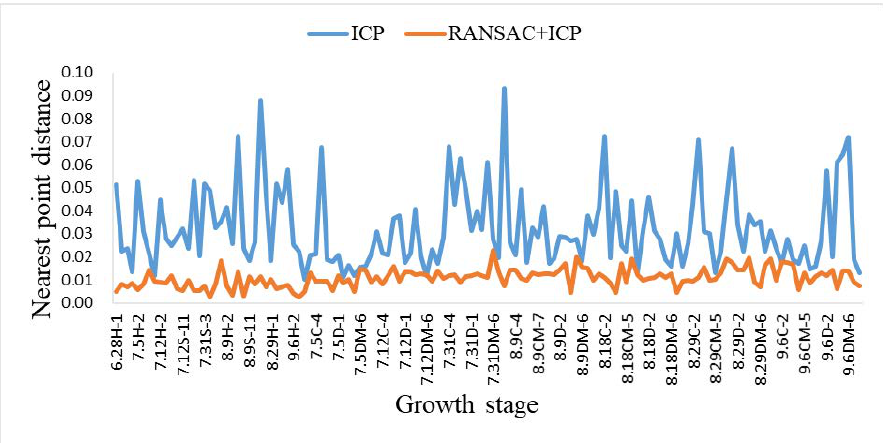
Figure 15. Comparison of the errors of the two